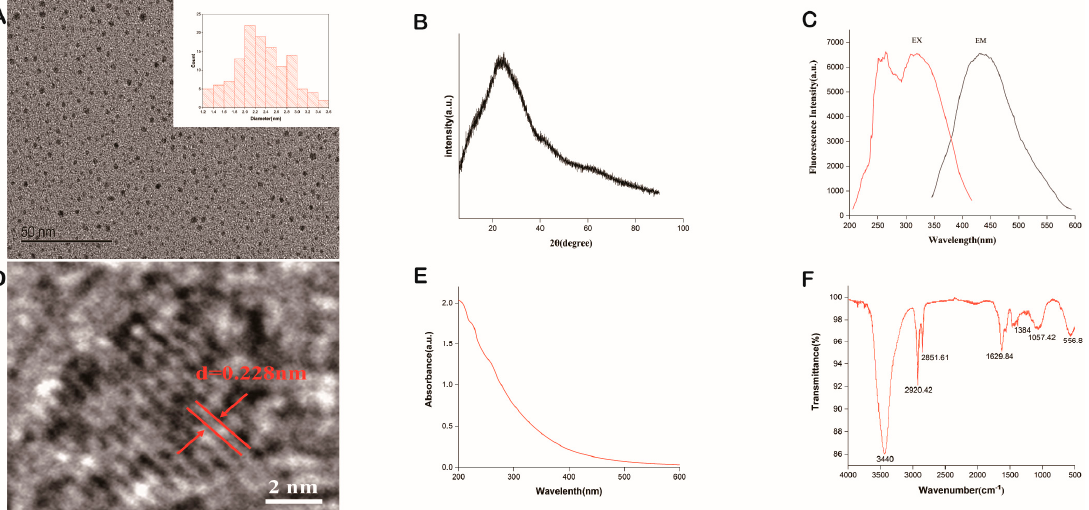
Figure 1. Characterization of Platycodon grandiflorum -based carbon dots (PGC-CDs). ( A ) Transmission electron microscope (TEM) images and histogram depicting particle size distribution. ( B ) X-ray Diffraction (XRD) pattern. ( C ) Fluorescence spectrum. ( D ) High-resolution TEM (HRTEM) image. € Ultraviolet-visible (UV-Vis) spectrum. ( F ) Fourier transform infrared (FTIR) spectrum.